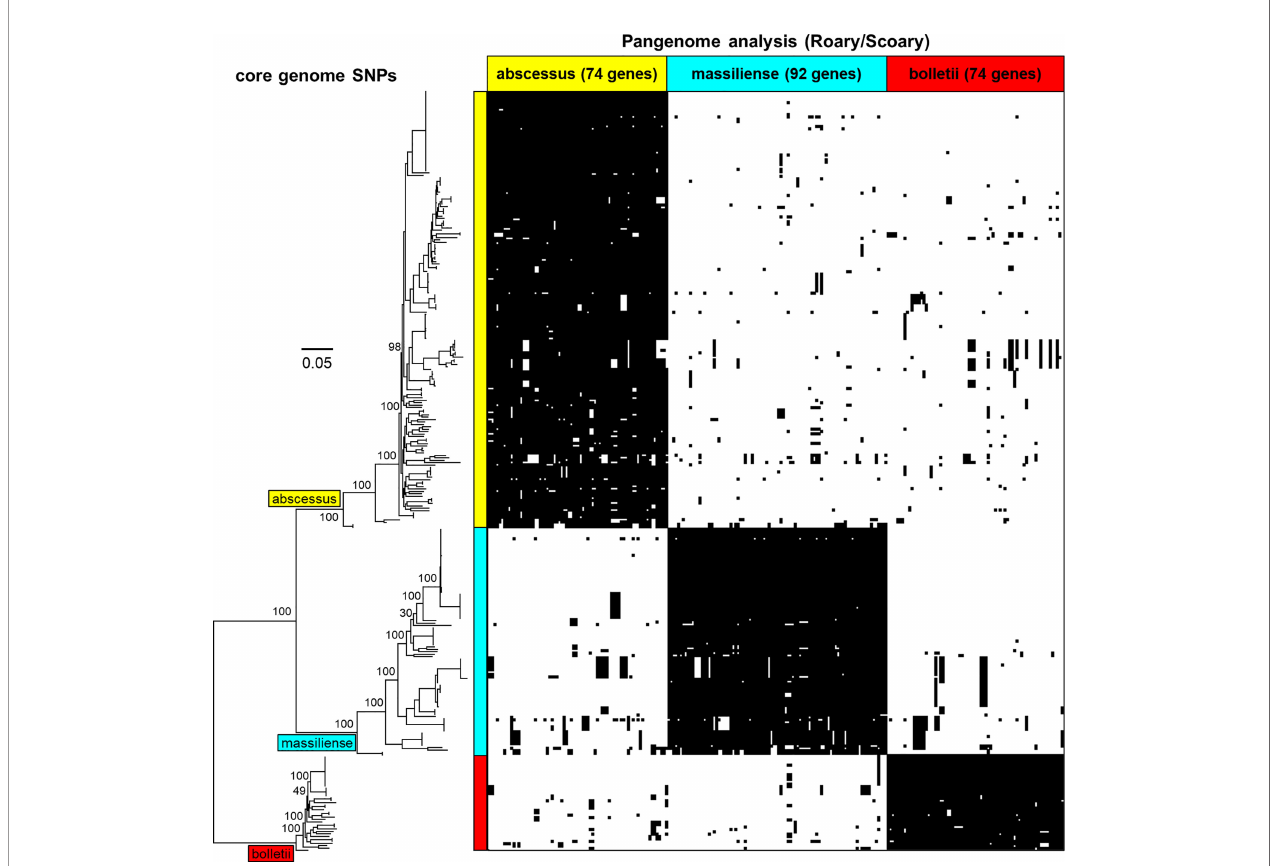
FIGURE 2 | Phylogenetic tree of the core genomes of the MABC subspecies - M. abscessus (yellow), M. massiliense (light blue) and M. bolletii (red) with pangenome matrix of genes speci fi c to MABC. The pangenome was determined using Roary and queried using Scoary based on the core genomes showing subspecies- speci fi c genes that are either present or absent. Bootstrap values based on ParSNP tree iterations (expressed in percentage) have been added to the major branches in the phylogenetic